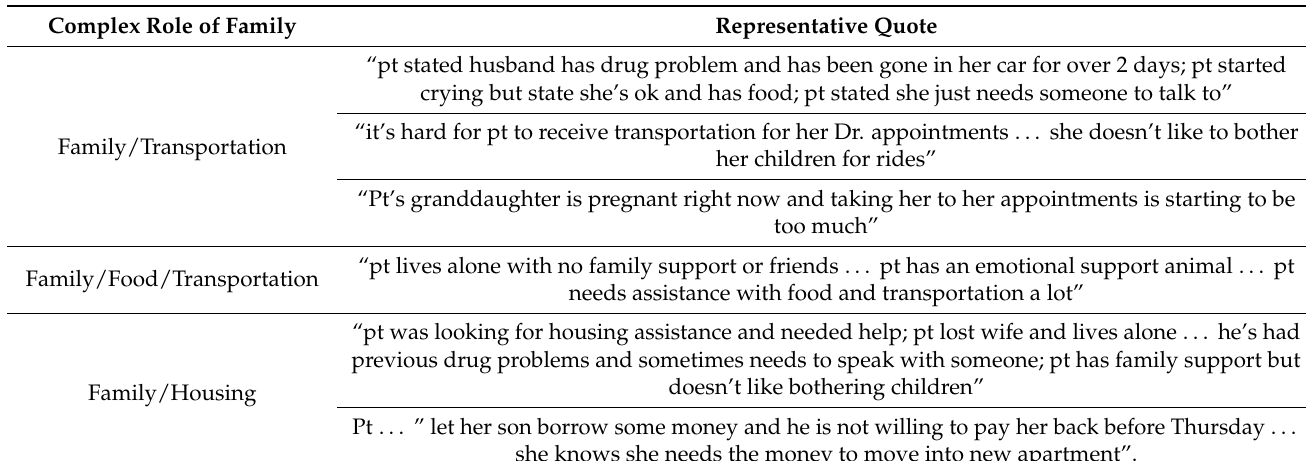
Table 4. Complex Role of Family for Social Support and Resource Access.